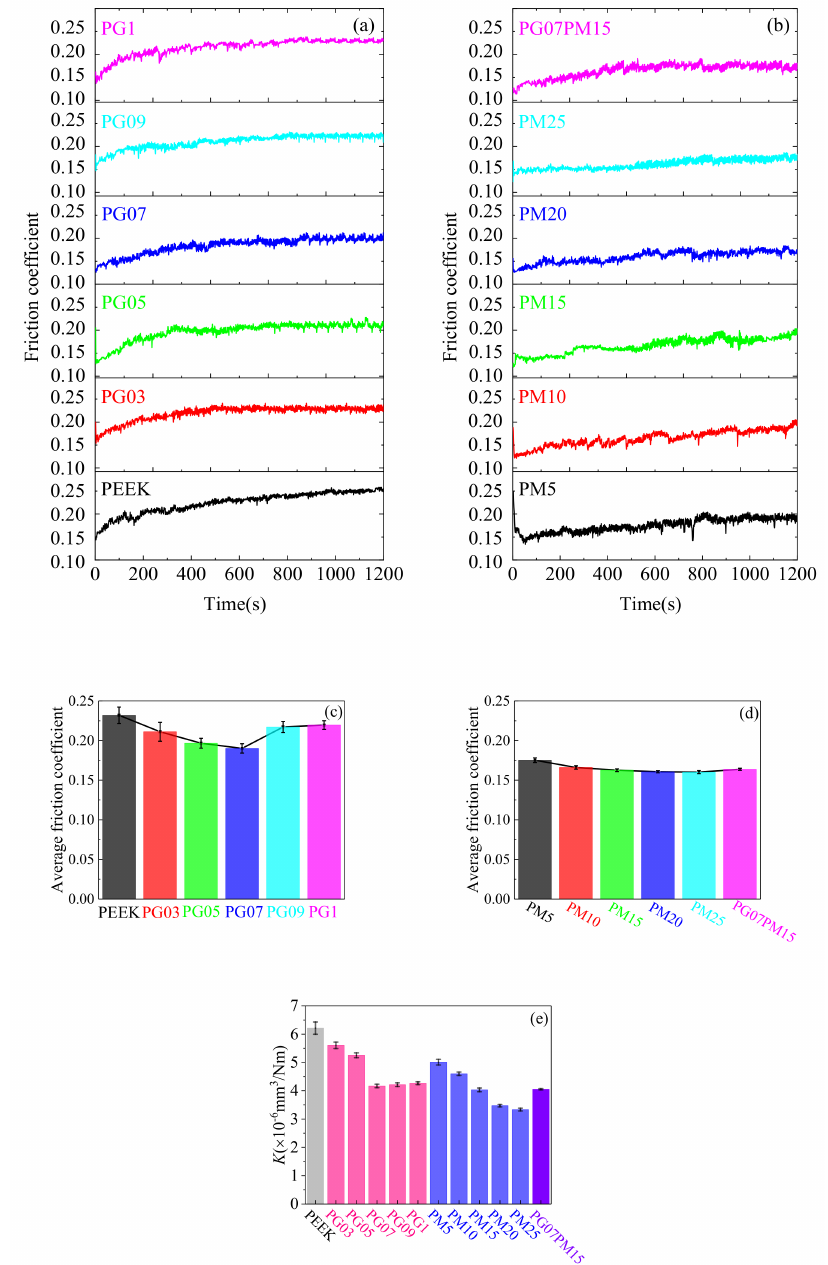
Figure 2. Friction coe ffi cient of poly-ether-ether ketone (PEEK) and PEEK / graphene oxides (GOs) ( a , c ), PEEK / MoS 2 s and PEEK / GO / MoS 2 ( b , d ), and wear rate of PEEK, PEEK / GOs, PEEK / MoS 2 s, and PEEK / GO / MoS 2 ( e